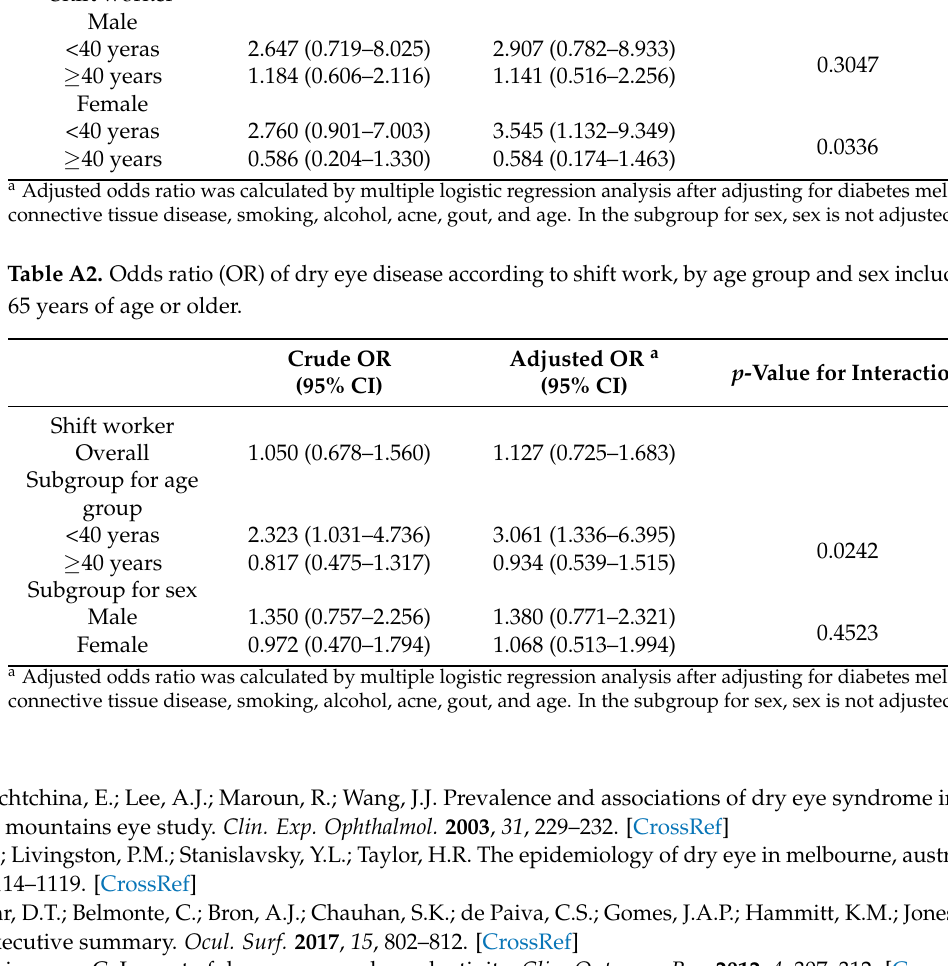
Table A1. Odds ratio (OR) of dry eye disease according to shift work, by age group in each sex group. Crude OR Adjusted OR a p -Value for Interaction (95% CI) (95% CI) Shift worker